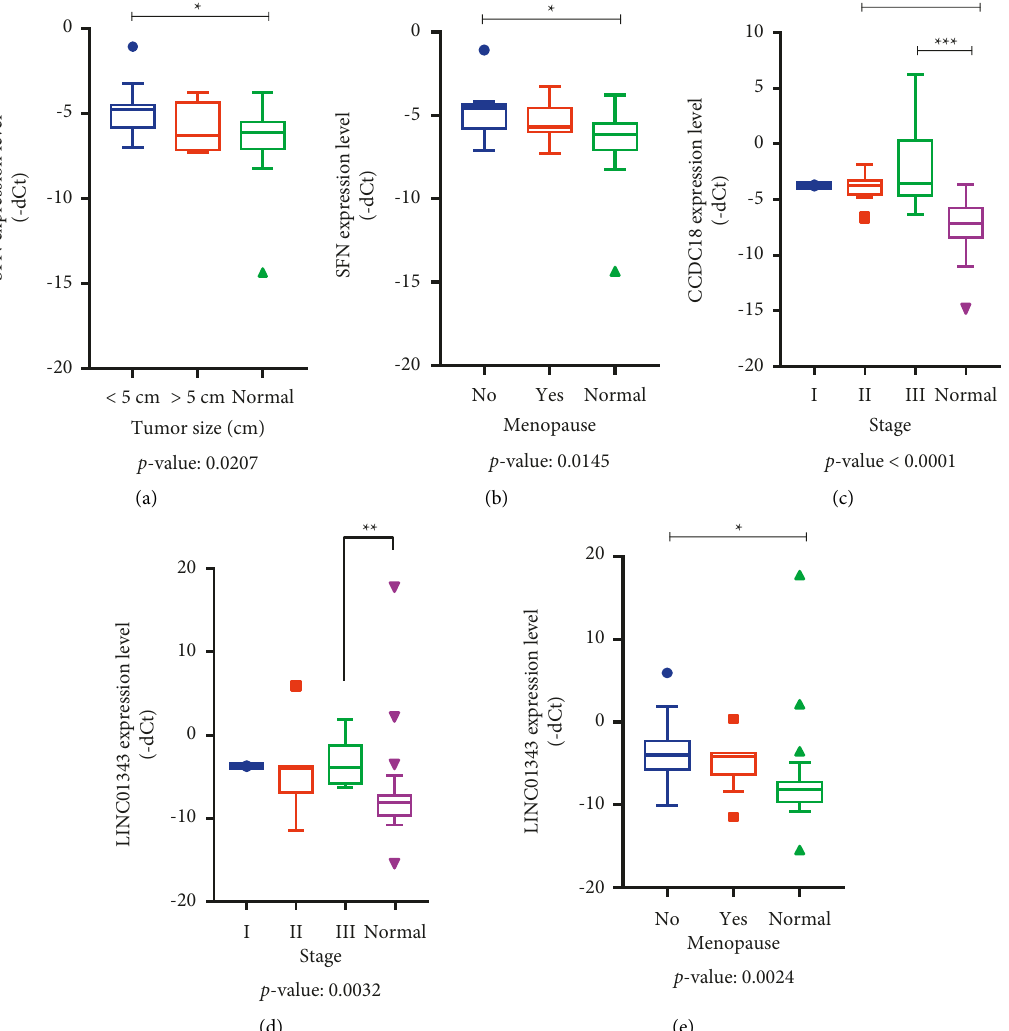
Figure 7: Clinicopathological analysis of BC tissues. QRT-PCR data of SFN , LINC01343, and CCDC18-AS1 were analyzed according to the clinicopathological parameters (stage, tumor size, and menopause ages) by KruskalWallis test.